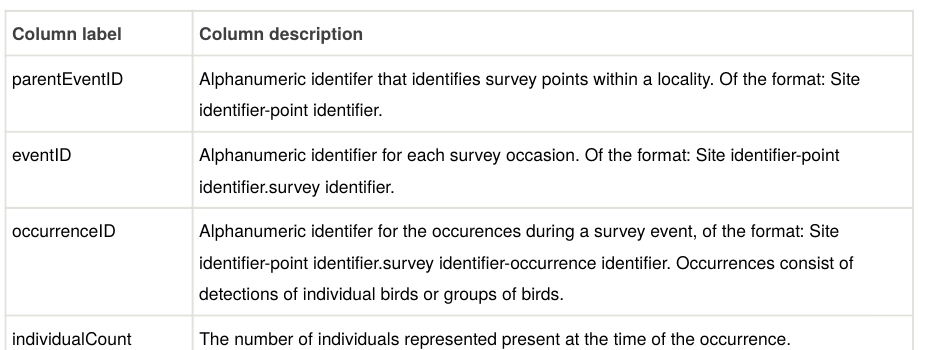
Description: A data table containing information on species occurrences generated during sampling events conducted January - March 2015 on Puerto Rico. This data table is linked to the resource samplingEvents.csv by the